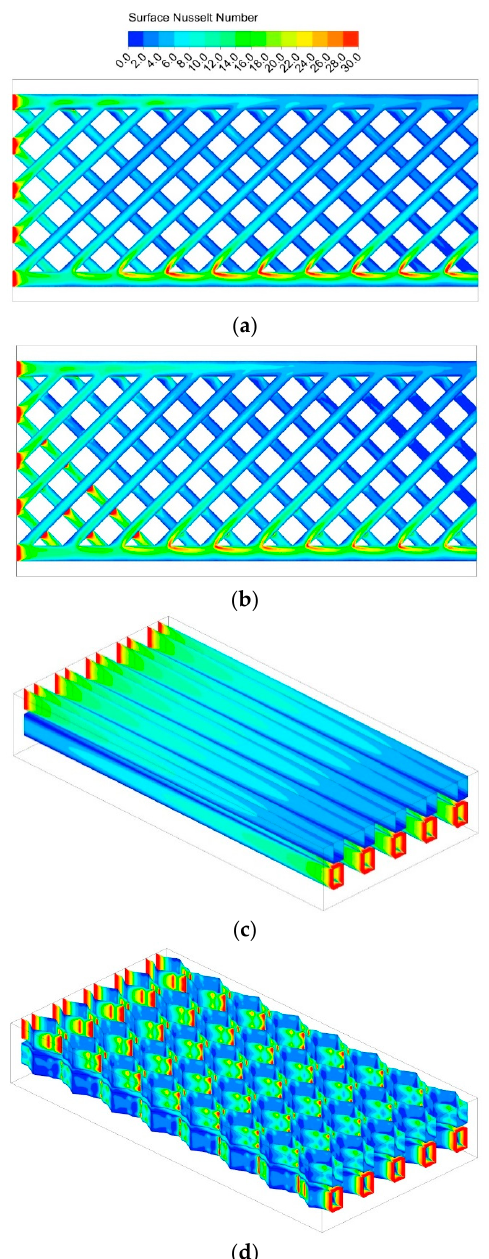
Figure 12. Nu number distribution of ( a ) DL-M channel, ( b ) DL-IM channel, ( c ) DL-R channel, and ( d ) DL-T channel when Re = 132.